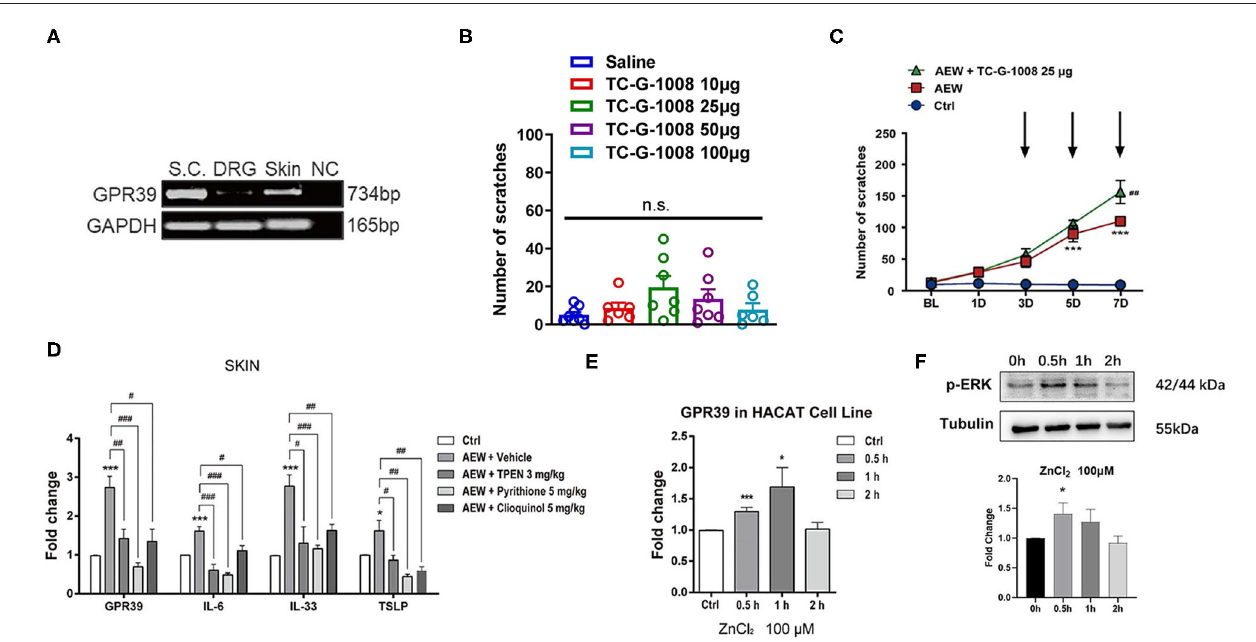
FIGURE 9 | GPR39 was possibly involved in dry skin-induced chronic itch in mice. (A) The RT - PCR results showed that GPR39 is expressed in the spinal cord and the skin of mice, and only little in the DRG. (B) A GPR39 agonist, TC-G-1008 (1–100 µ g) was not able to evoke acute itch in mice (one-way AVOVA following post-hoc Bonferroni’s test; n = 6–8). (C) TC-G-1008 (25 µ g) significantly increased AEW-induced chronic itch in mice (*** P < 0.001 vs Ctrl, ## P < 0.01 vs. AEW, two-way ANOVA following post-hoc Bonferroni’s test; n = 8). (D) The expression of Gpr39 , Il-6 , Il-33 , and Tslp in the skin of dry skin induced chronic itch model (* P <